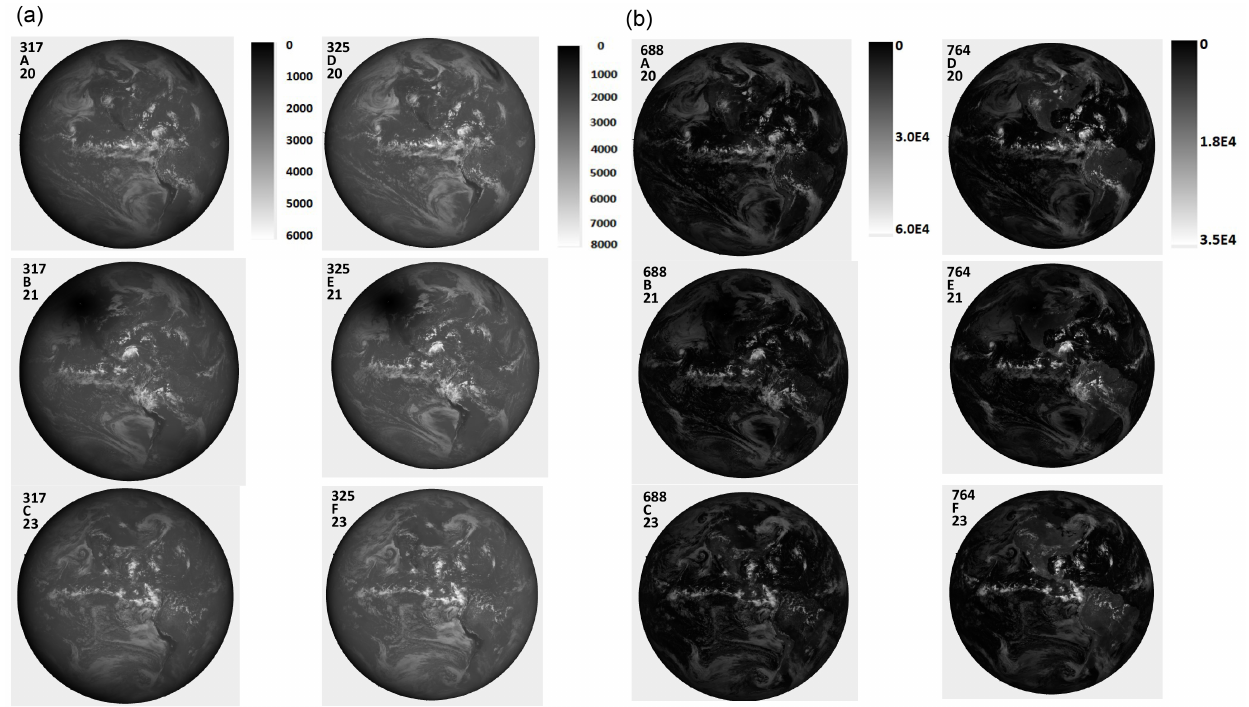
Figure A2. (a) Image in counts per second for 317 and 325nm and (b) image in counts per second for 688 and 764nm for 20, 21, and 23 August. The scale applies to the specific wavelength. North is up.